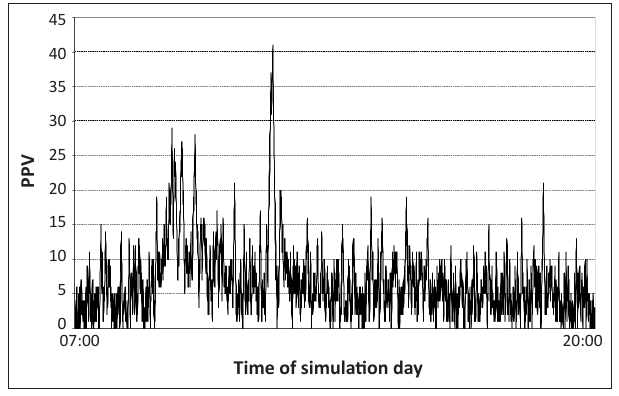
FIGURE 4: Persons-per-viewscape along the trail to Bridalveil Fall in Yosemite National Park,